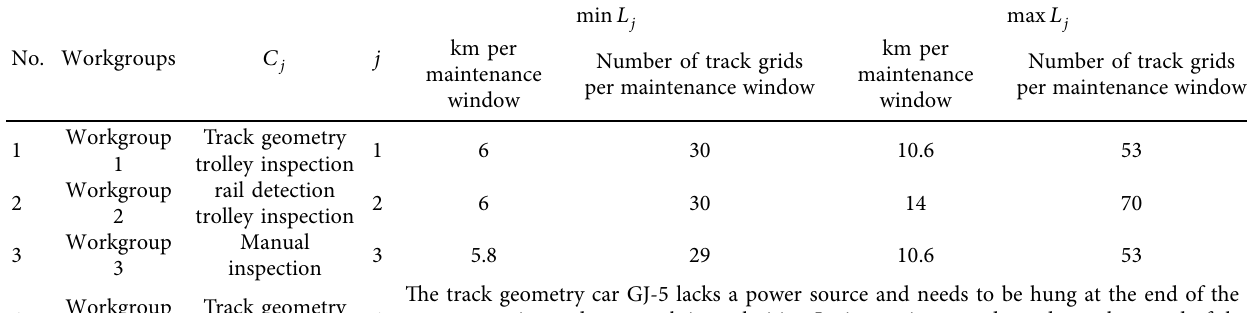
Table 3: Rate constraints of different inspection methods.